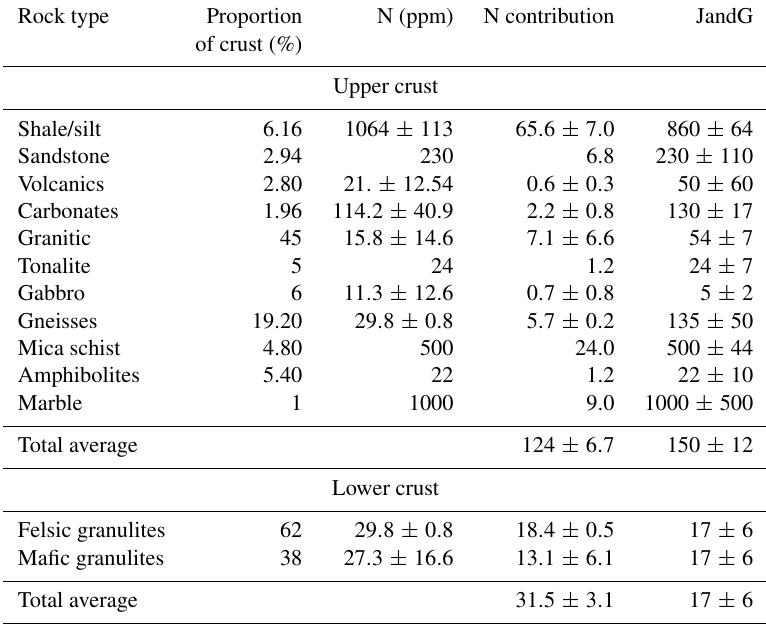
Table 6. Nitrogen concentration in upper and lower-crustal rocks based on Wedepohl (1995). Proportions are of upper or lower-crust mass; N concentration (ppm) is from this study (where error is shown) or from Johnson and Goldblatt (2015) (JandG). Nitrogen contribution is simply concentration multiplied by the proportion of crust. We use gneisses as a proxy for felsic granulites and xenoliths for mafic granulites. Values from Johnson and Goldblatt (2015) are given for comparison, with error shown as standard error of the